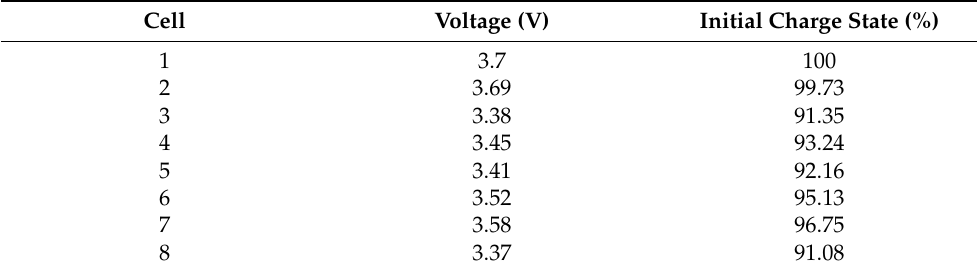
Table 1. Initial parameters for simulating the passive equalization